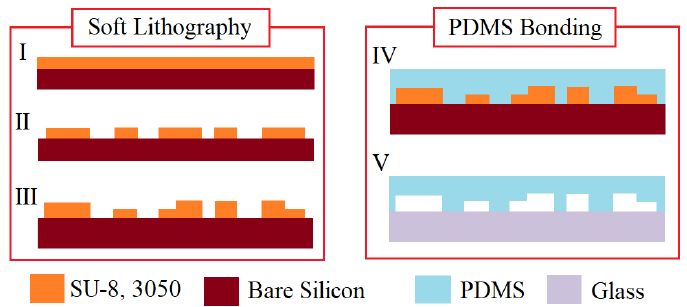
Figure 4. Fabrication process of the blood cells separation device. I-III are the steps for standard lithography with the negative photoresist SU8. IV–V are the steps for soft lithography with polydimethylsiloxane (PDMS) and then bonding the device on a glass substrate after plasma treatment. Note: (I–III), the SU8 process follows the standard procedure, provided from official data sheet. A two layers of SU8 are made: a first SU8 layer with a 20–50 μm thickness is spun-coated at 1500 rpm, exposed and baked; a second SU8 layer is then coated upon, exposed and baked with similar processing parameters.